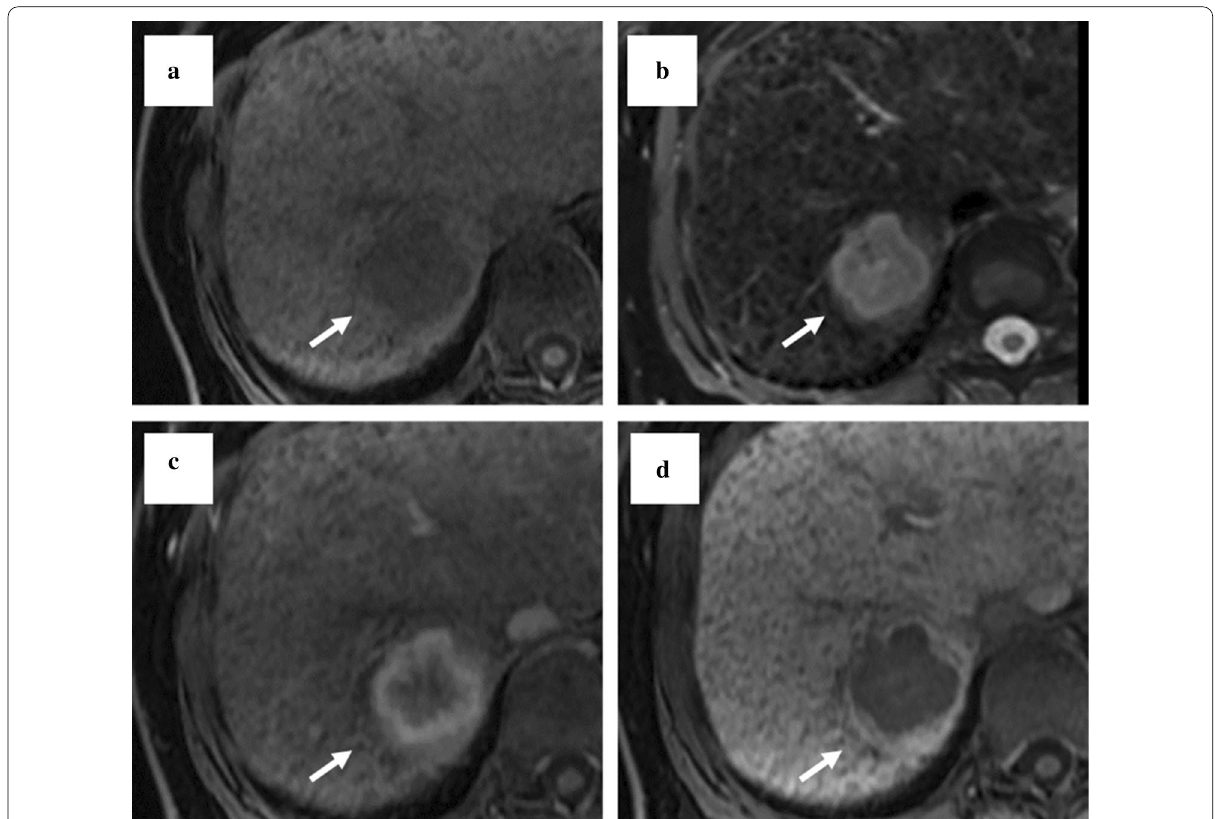
Fig. 2 Findings of magnetic resonance imaging (MRI). a The tumor shows a low signal intensity on a T1-weighted image. b The tumor shows a high signal intensity on a T2-weighted image. c At the early phase on ethoxybenzyl magnetic resonance imaging (EOB-MRI), the tumor shows ring-like enhancement. d The enhancement is not detected throughout the tumor in the hepatocyte phase on EOB-MRI